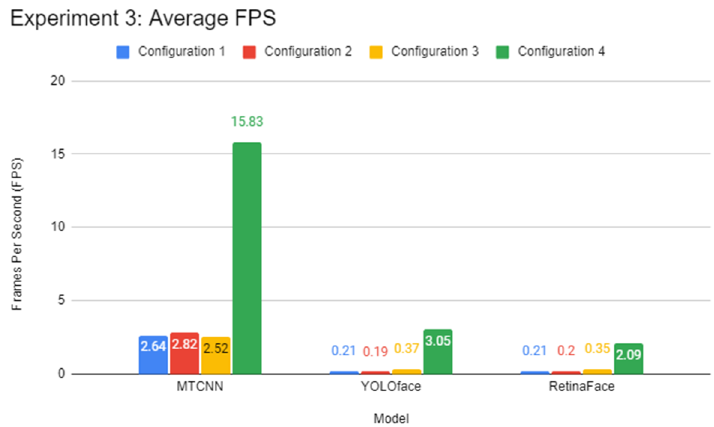
Figure 9. Average FPS results for Experiment 3.